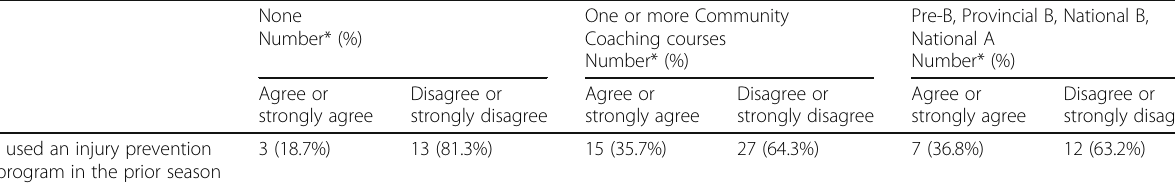
Table 5 Relationship between coaching course completion and intervention